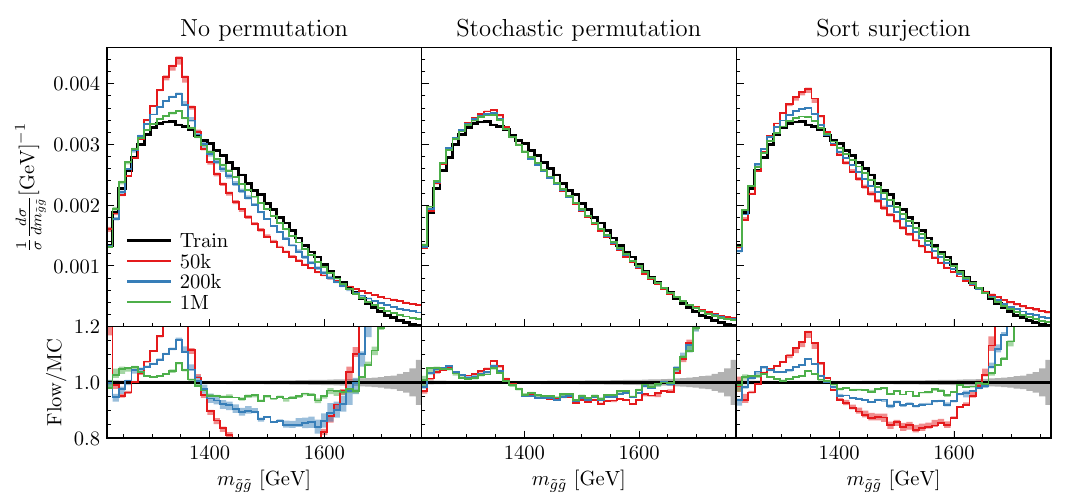
Figure 5: The digluino invariant mass as predicted by models trained on sets of training data of size 50k (red), 200k (blue) and 1M (green), without permutation transform (left), with stochastic permutation (middle) or with sort surjection (right). The error bands correspond with variations between three independent runs.